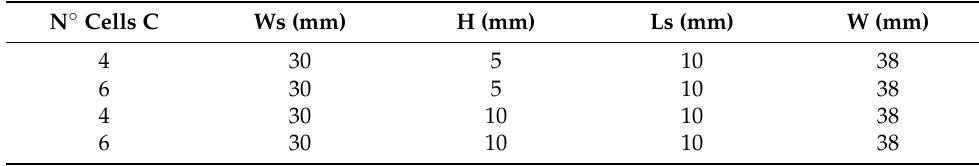
Table 1. Configurations of the geometric